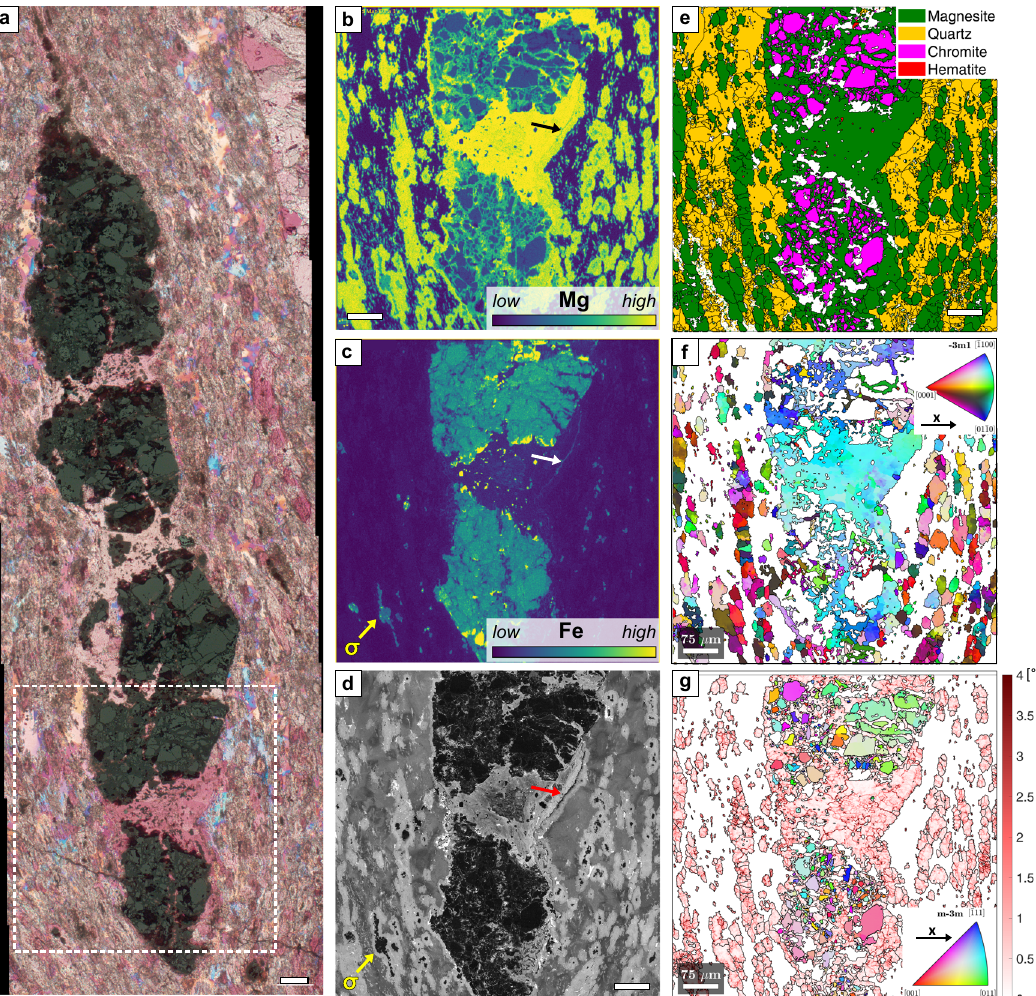
Fig. 3 Boudinage of Cr-Spinel in foliated listvenite. a Combined re fl ected and crossed-polarized light image with 1 λ -plate. b , c Mg and Fe chemical maps of the area indicated in a , showing Fe-rich magnesite between spinel fragments and a Fe-bearing seam at the contact between magnesite in the boudin neck and the quartz-magnesite matrix (white arrow). Fe-magnesite in the core of an ellipsoid forms a sigma-clast in the matrix (yellow arrow, σ ). d Scanning-electron microscopy cathodoluminescence (SEM-CL) image of the same area showing different magnesite generations and growth zoning in quartz. e Phase map from electron backscatter diffraction (EBSD). f Crystallographic orientations of magnesite (inverse pole fi gure (ipf) color scale: see inset). g Crystallographic orientation of chromite fragments (ipf color scale see inset) and kernel average misorientation of magnesite, showing low-angle boundaries in red. (Sample BT1B_14-3_77-80). Scale bars: 75